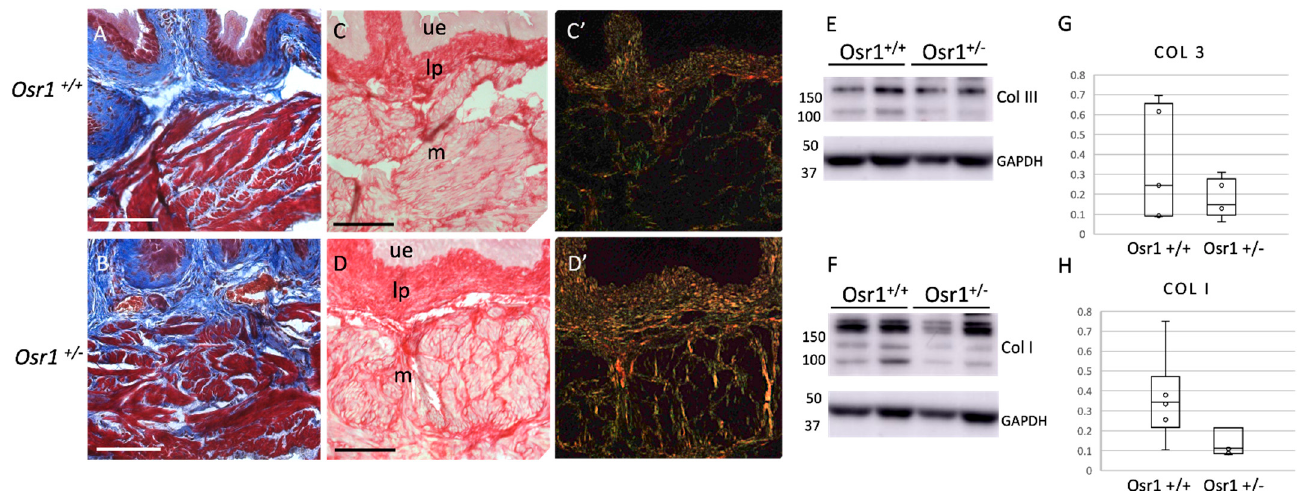
Figure 5. Osr1 +/ − adult mouse bladders have an increase in collagen: Masson’s trichrome staining of bladder sections of Osr1 +/+ ( A ) and Osr1 +/ − ( B ) mice. There is an increase in collagen (blue) in the muscle layer of Osr1 +/ − mice. Sirius red of Osr1 +/+ ( C , C’ ) and Osr1 +/ − ( D , D’ ) also show increased collagen between muscle bundles in Osr1 +/ − mice, n = 3 bladders/genotype. Quantitative analysis of western blot showing Col III ( E , G ), and Col I ( F , H ) protein normalized to GAPDH. There are comparable levels of collagens in both Osr1 +/+ and Osr1 +/ − . Scale bars = 100 µ m. ue = uroepithelial layer, lp = lamina propria, m =